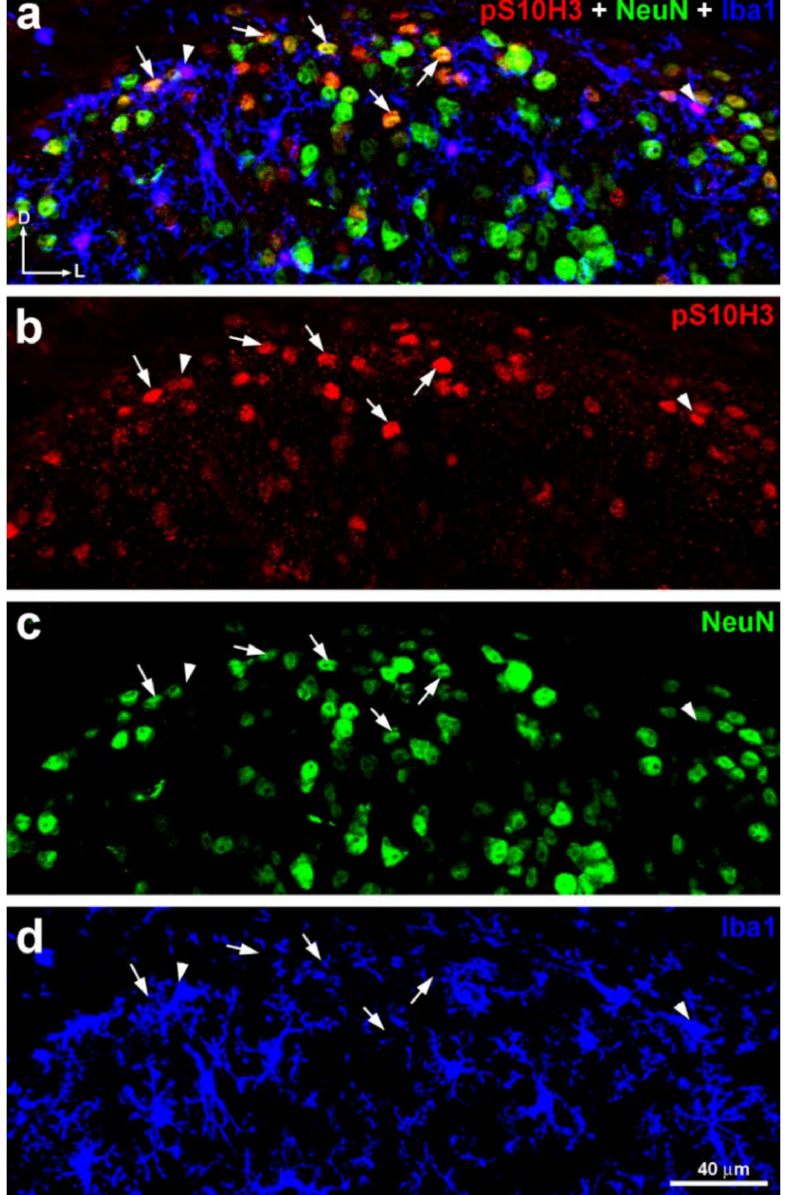
Figure 3. p-S10H3 was upregulated mainly but not exclusively in SDH neurons in mice after burn injury. ( a – d ) Immunostaining with antibodies against p-S10H3 (red; b ), Fox-3 (NeuN) (green; c ), and Iba-1 (blue; d ) in a transverse section of wild-type mouse. The merged image ( a ) clearly shows that almost all p-S10H3 positive nuclei are located in NeuN-positive somata (arrows) indicating that majority of them belong to neuronal population. Arrowheads label p-S10H3-expressing microglial cells. D, dorsal; L,